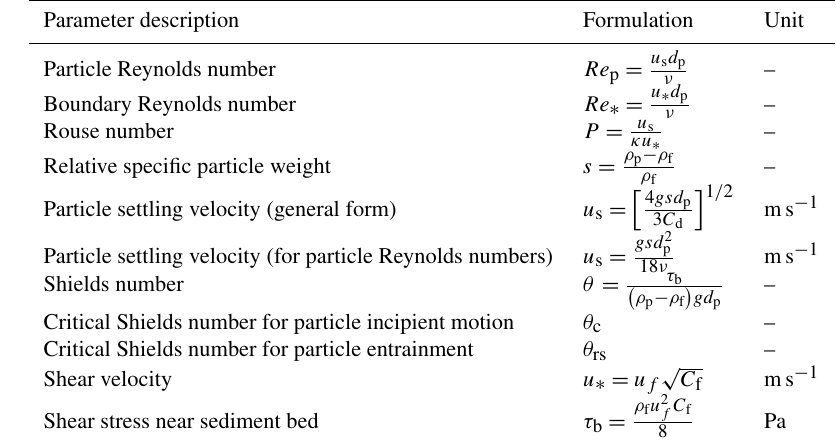
Table 1. Definitions of key parameters. Symbol d p is used for the particle diameter, ρ p and ρ f represent mass particle and fluid density, respectively, κ is the von Kármán constant, ν is the (temperature-dependent) kinematic viscosity of water, g is the gravitational acceleration (taken as 9.81ms 2 ), C d is the friction factor, and C f is the Darcy friction factor (taken as 0.02 in this study unless otherwise mentioned).